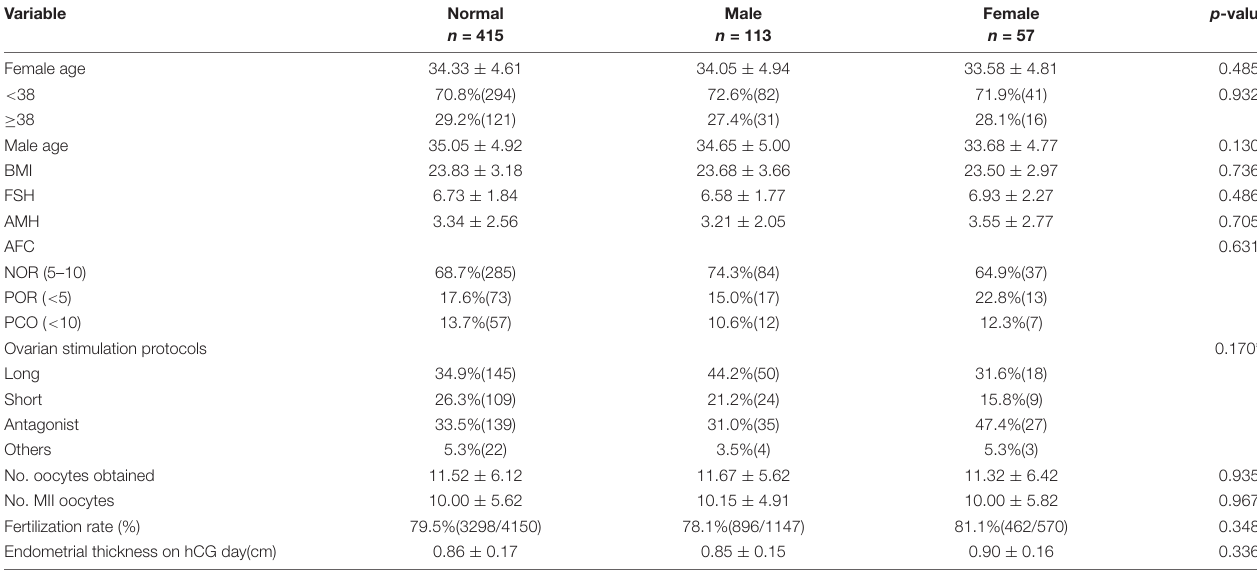
TABLE 1 | Baseline characteristics of uRPL